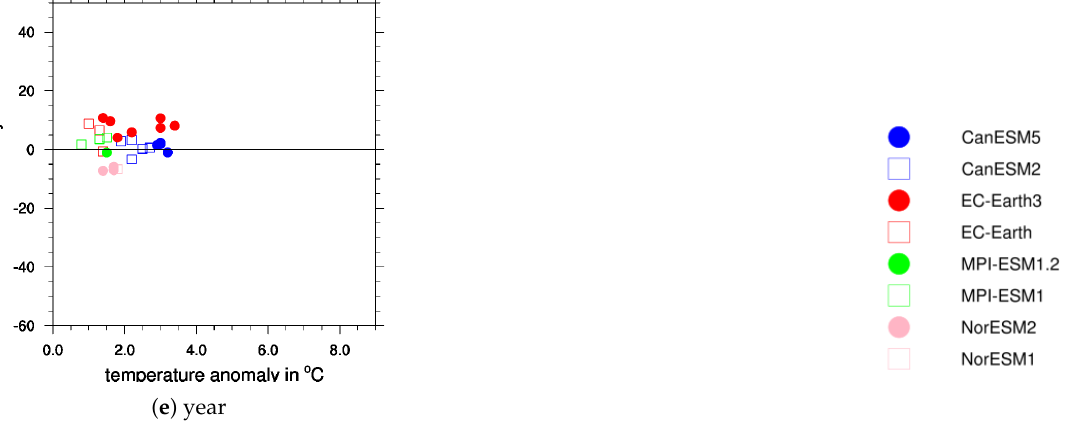
Figure A2. Comparison of EPISODES downscaling results based on RCP4.5 (CMIP5) and SSP2-4.5 (CMIP6) for Germany. The symbols (open: CMIP5; filled: CMIP6) show the Germany-wide mean climate change signal in annual/seasonal precipitation and temperature for 2041–2070 with respect to 1971–2000. Different colours correspond to different GCMs. (Seasons: ( a ) spring (MAM), ( b ) summer (JJA), ( c ) autumn (SON), ( d ) winter (DFJ), ( e )